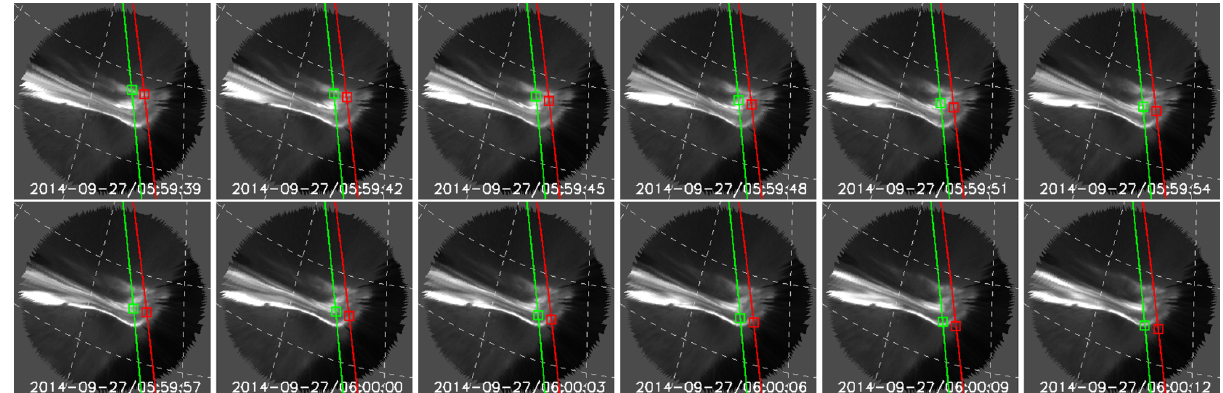
Figure 12. Mapped optical frames in geographic coordinates from FSMI station. The tracks show the ionospheric projection of SwA (green) and SwC (red). At the time of the frame the spacecraft mapped position is shown by the square symbols. The time is overplotted on each frame and covers the interval from 05:59:39 to 06:00:12.